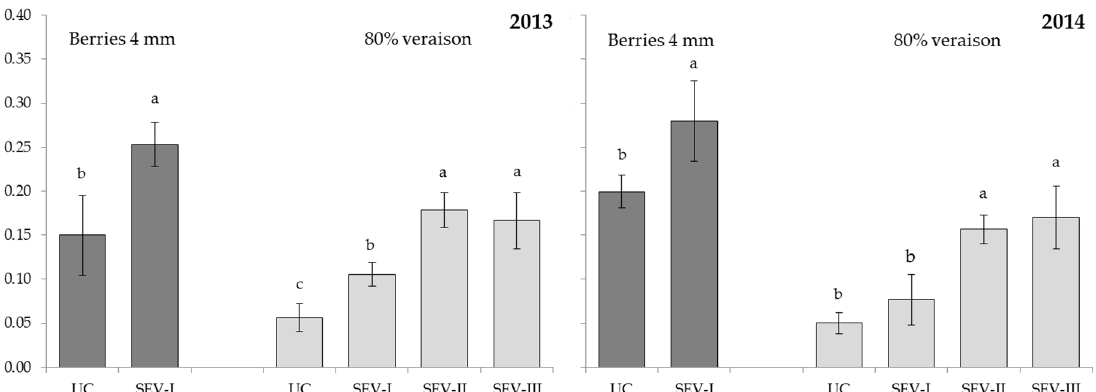
Figure 2. Photosynthetically active radiation (PAR) values in fruit zones for untreated control (UC) and severe shoot trimming treatments applied at different phenological stages (SEV-I, severe shoot trimming when berries were 4 mm in diameter; SEV-II, severe shoot trimming at early veraison; SEV-III, severe shoot trimming at late veraison). Dark grey columns represent PAR values measured one day after the application of SEV-I and light grey columns represent PAR values measured one day after the application of SEV-III. Data were analyzed by one-way ANOVA in randomized blocks design. Different letters identify significantly different means. Table 2. Yield components of Merlot grapevines subjected to severe shoot trimming at different phenological stages (mean values for 2013 and 2014). UC, untreated control; SEV-I, severe shoot trimming when berries were 4 mm in diameter; SEV-II, severe shoot trimming at early veraison; SEV-III, severe shoot trimming at late veraison.